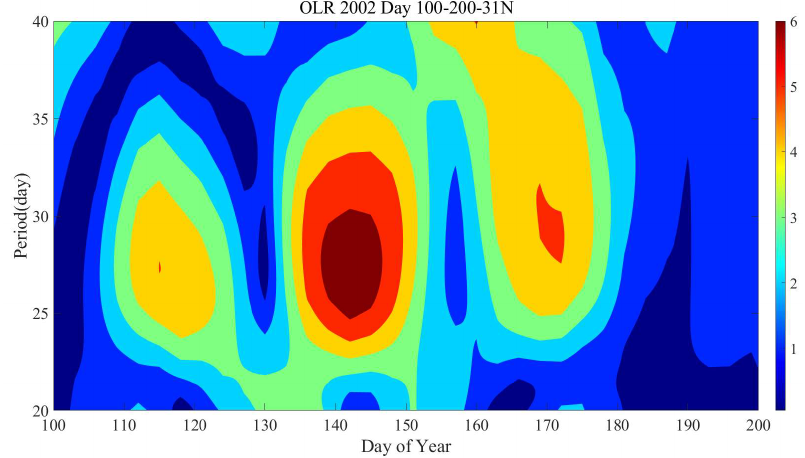
Figure 11. The period–time power spectra of OLR during Days 100-200,